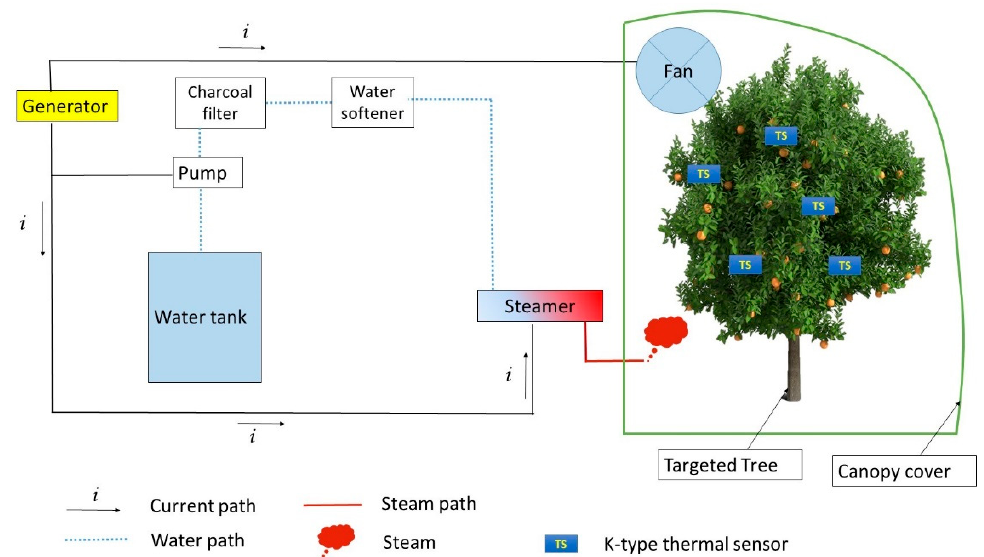
Figure 1. Schematic diagram of mobile thermotherapy system for heat-treating huanglongbing (HLB)-affected trees in the field [4].